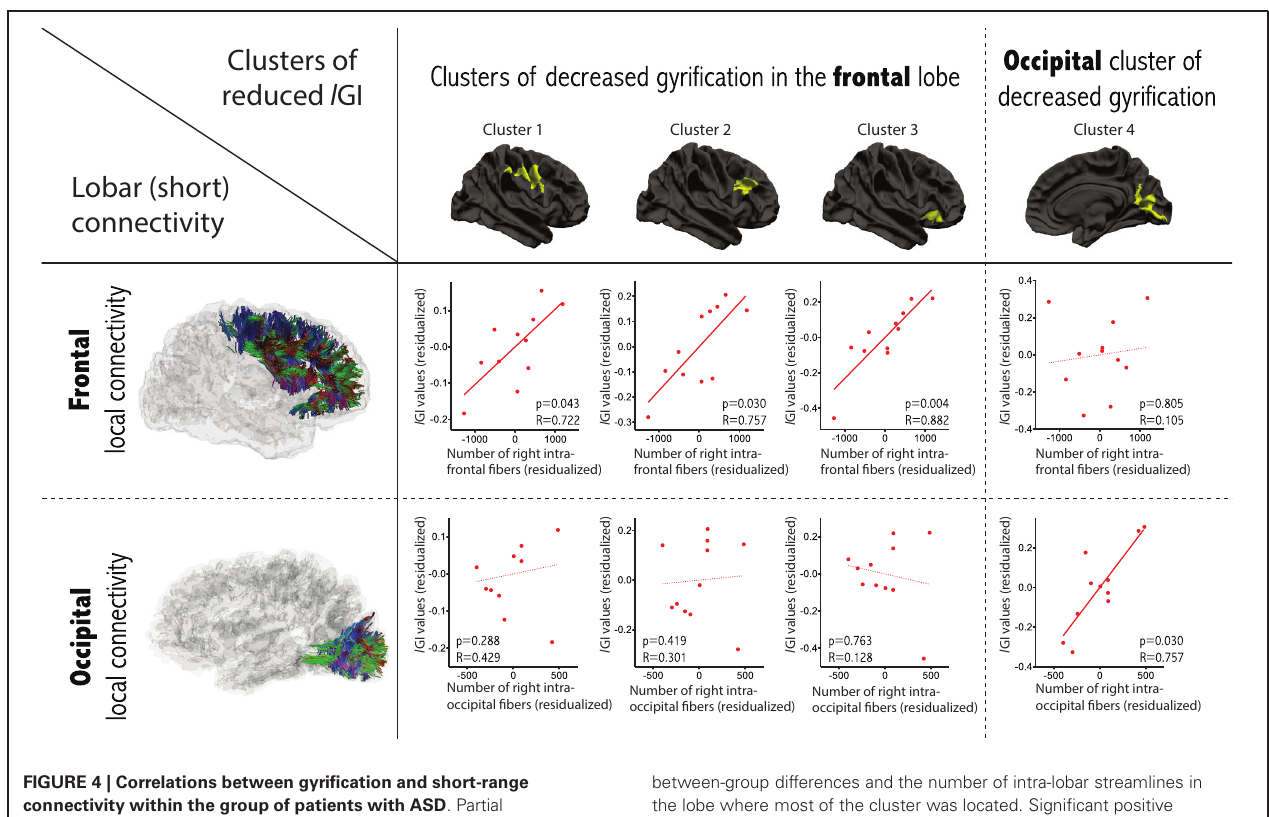
FIGURE 4 | Correlations between gyrification and short-range connectivity within the group of patients with ASD . Partial correlations accounting for age, gender and total number of streamlines were conducted between l GI in the cluster of